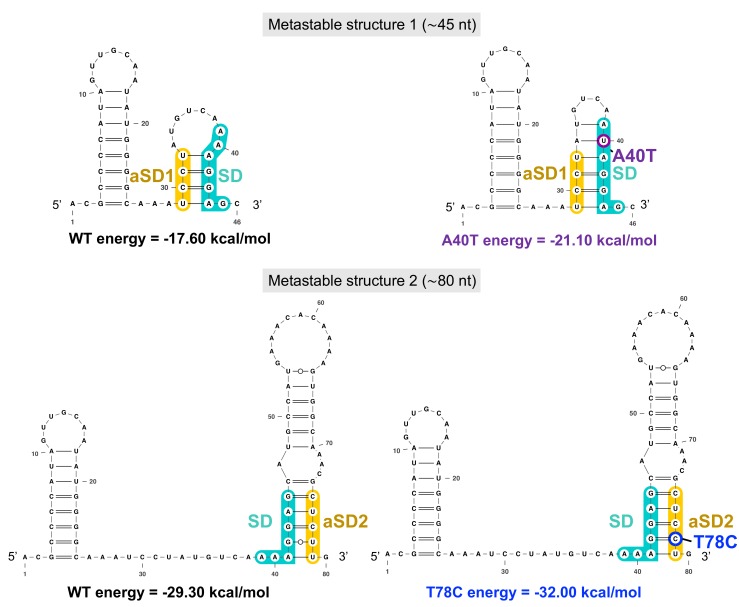
The two successive aapA3 mRNA metastable structures have increasing stability and are stabilized by the A40T and the T78C suppressor mutations.The two metastable structures (1, ≈46-nt long, upper panel; and 2, ≈80-nt long, lower panel) successively formed during aapA3 mRNA transcription are shown. Shine-Dalgarno (SD) sequence is highlighted in turquoise, anti-SD (aSD) sequences (aSD1 and aSD2) are highlighted in yellow, the suppressor mutation stabilizing SD sequestration by aSD1 in the metastable structure 1 is highlighted in purple (A40T), the suppressor stabilizing the SD sequestration by aSD2 in the metastable structure 2 is highlighted in blue (T78C). RNAfold (Gruber et al., 2008) was used for secondary structure and minimum free energy predictions, and VARNA (Darty et al., 2009) for drawing.